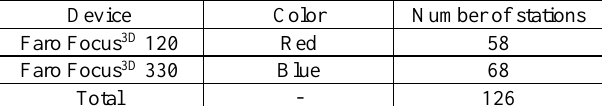
Table 1. Number of stations from TLS